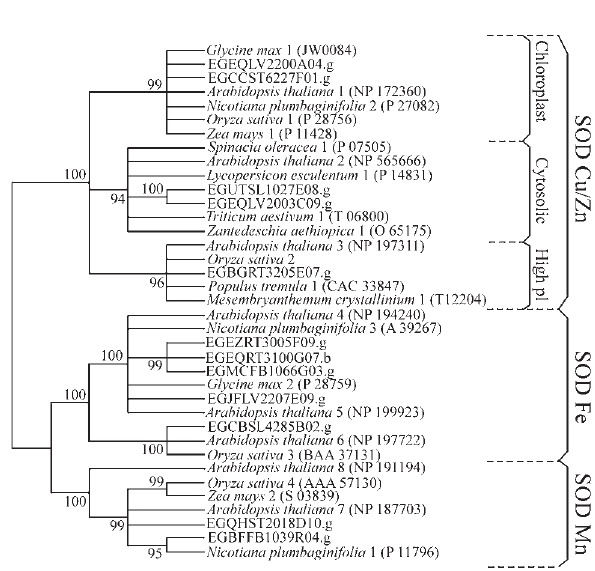
Figure 2 - Phylogenetic tree of SOD proteins. Phylogenetic analyses were conducted using the software MEGA Version 2.1. Molecular distances were calculated using the parameter of p-distance, and the trees were con- structed using the Neighbor-Joining method with pairwise deletion. The test of phylogeny used was the Interior Branch Test with 1000 replica- tions.Confidencetestvalues90%areshown.Proteinsequencesareidenti- fied by their accession number at NCBI.